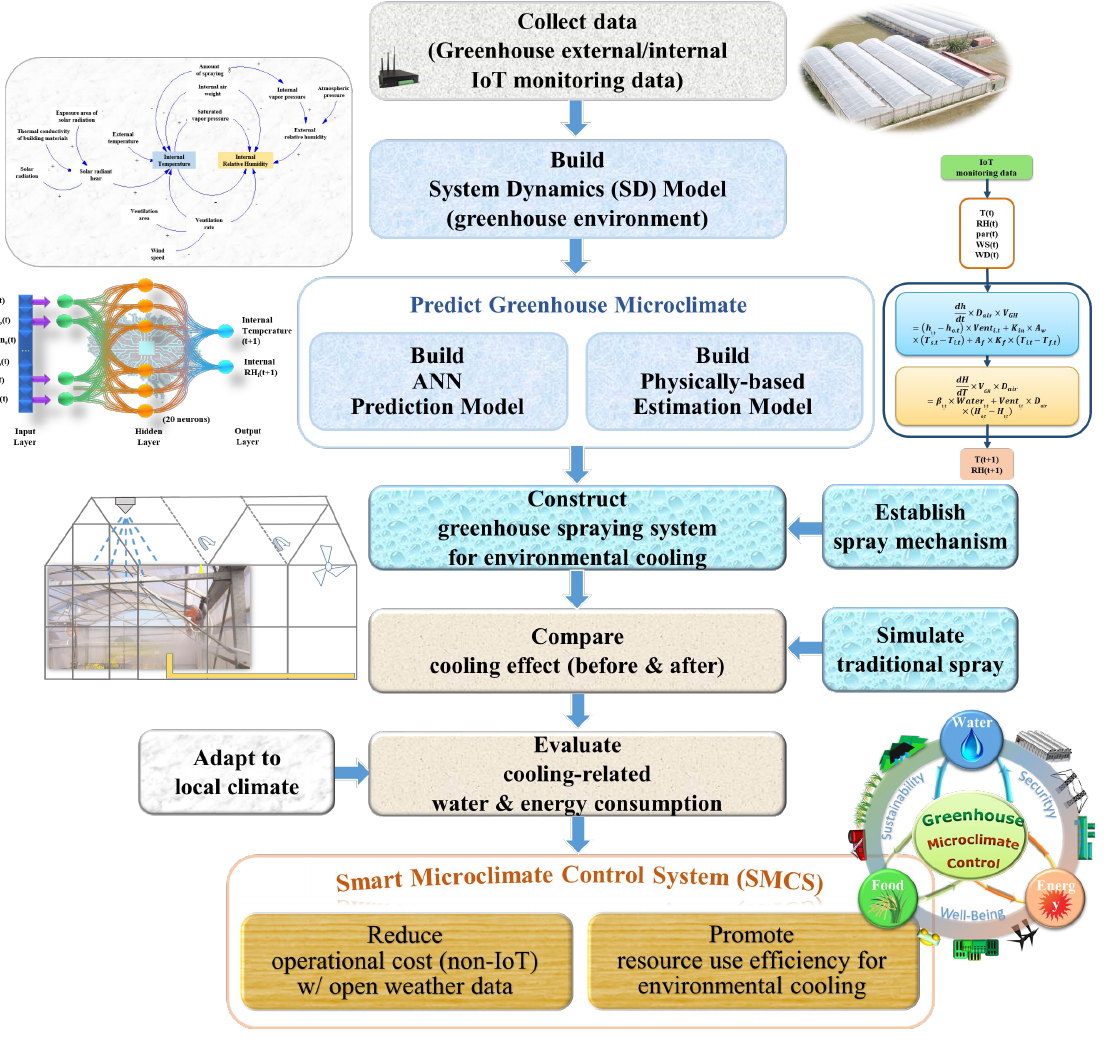
Figure 1. Research flow chart of this study.